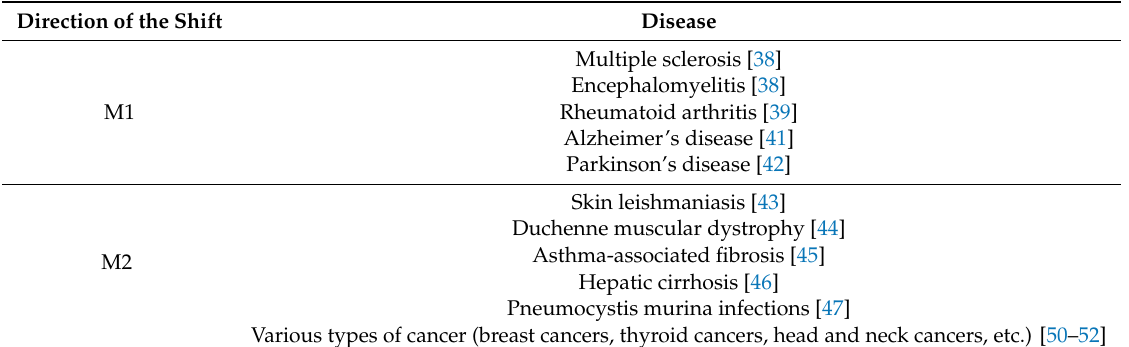
Table 2. The examples of M1 / M2 shift in inflammatory and proliferative